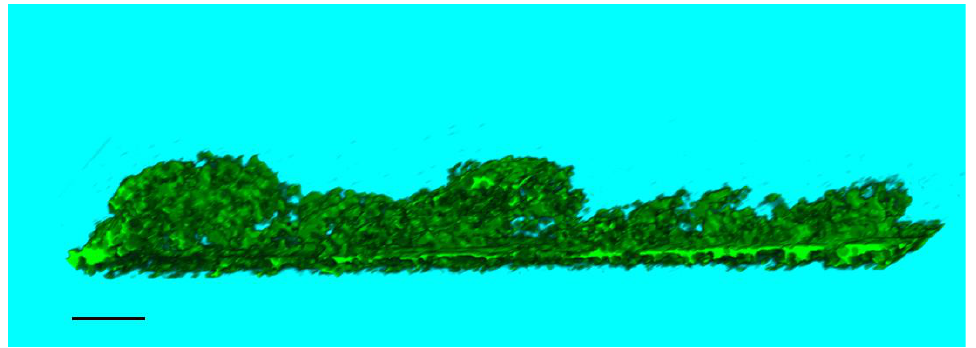
Figure 5. Visualization of three-dimensional model of the microparticles of decellularized rat liver tissue on the surface of a SF-MP scaffold reconstructed by SPNT technique: reconstructed volume 22.40 × 4.70 × 2 .25 μm, number of sections 15, section thickness 150 nm, scale bar 2 μm